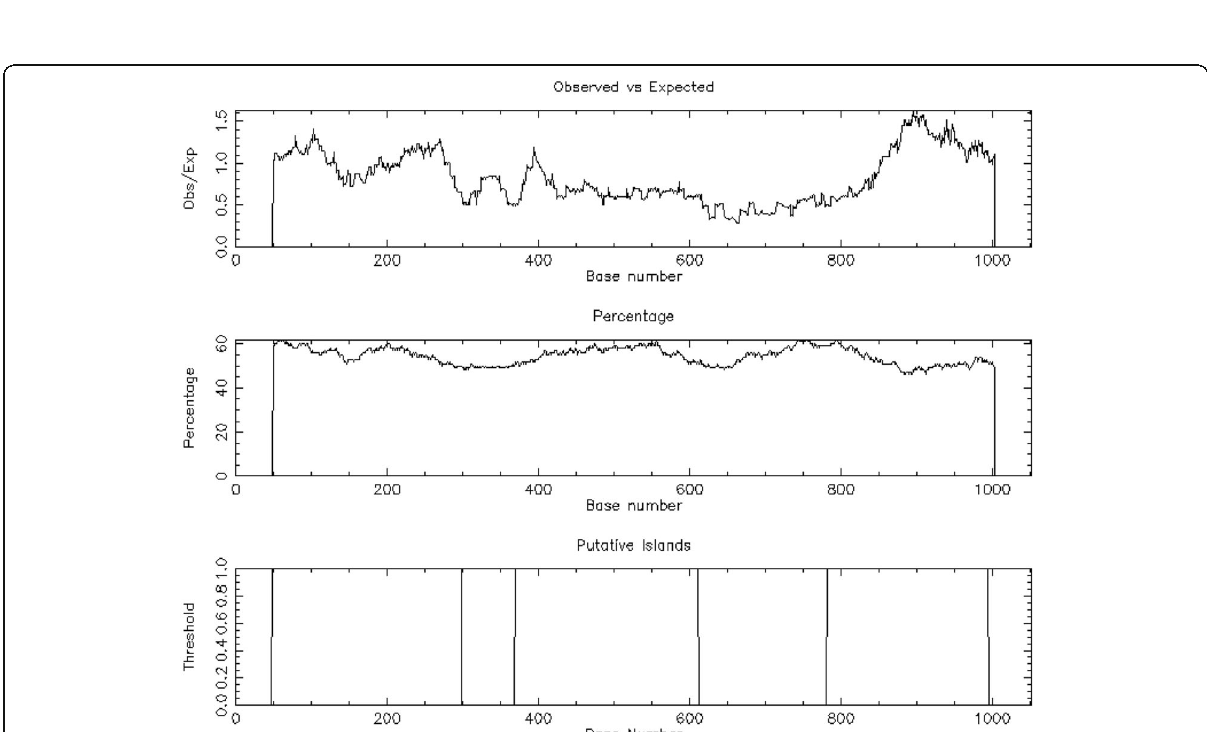
Fig. 6 CPGPLOT islands of three regions of adh1 gene; from 1 to 1053 with length 251 (49 – 299), length